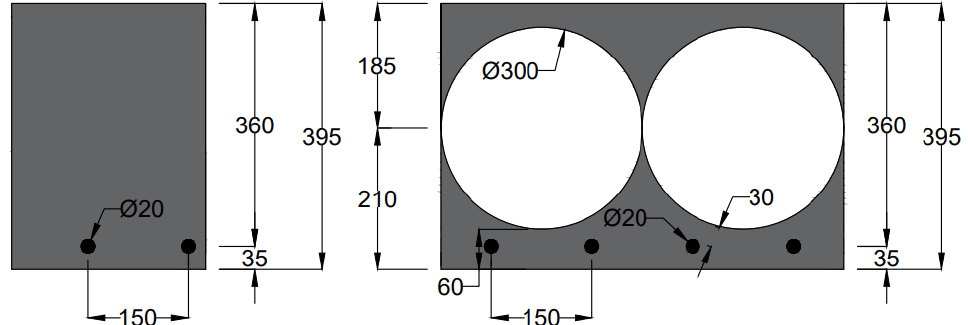
Figure 7. Cross-sections of the solid and hollow sphere slabs dimensioned according to [5] (all di- mensions in mm).